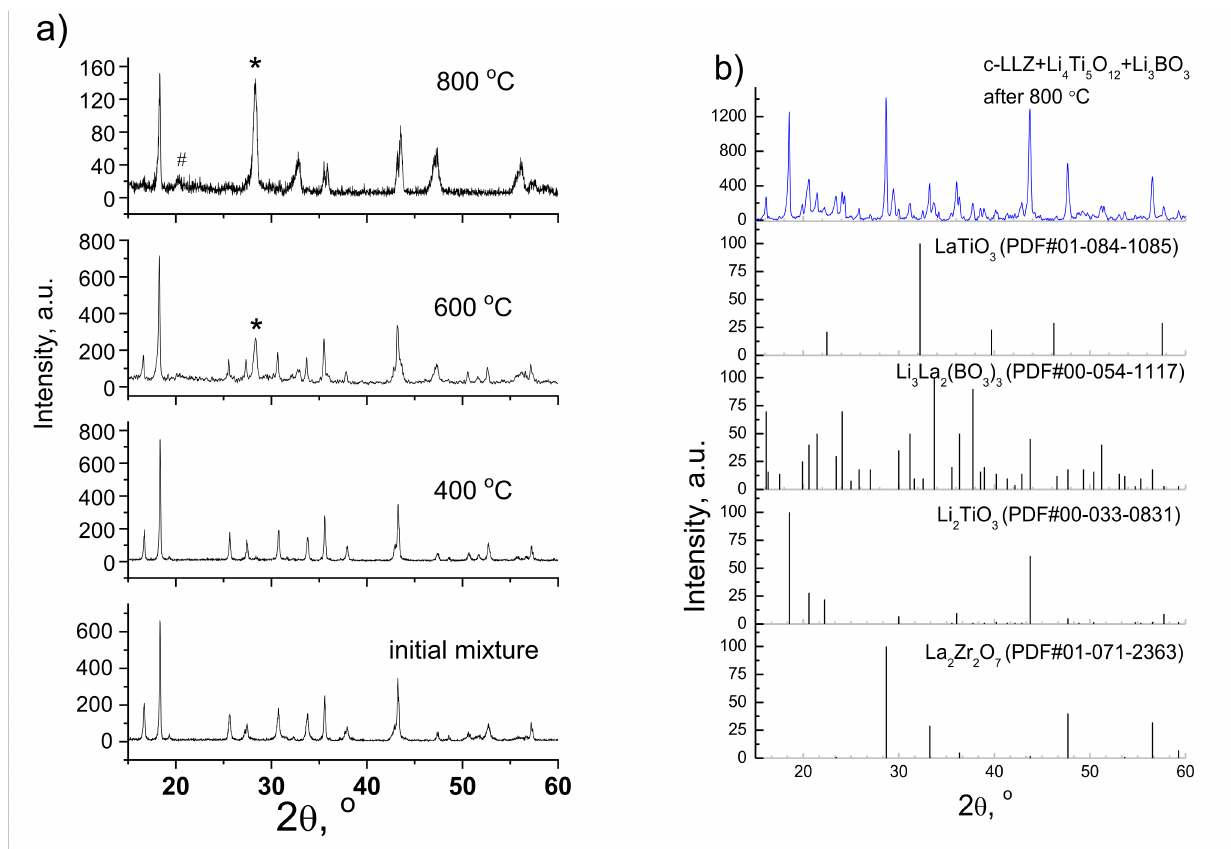
Figure 7. XRD patterns of Li 4 Ti 5 O 12 + c-LLZ (1:1) mixture annealed at different temperatures ( a ) and c-LLZ + Li 4 Ti 5 O 12 + Li 3 BO 3 (1:1:1) annealed at 800 ◦ C ( b ). *—La 2 Zr 2 O 7 , #—Li 2 TiO 3